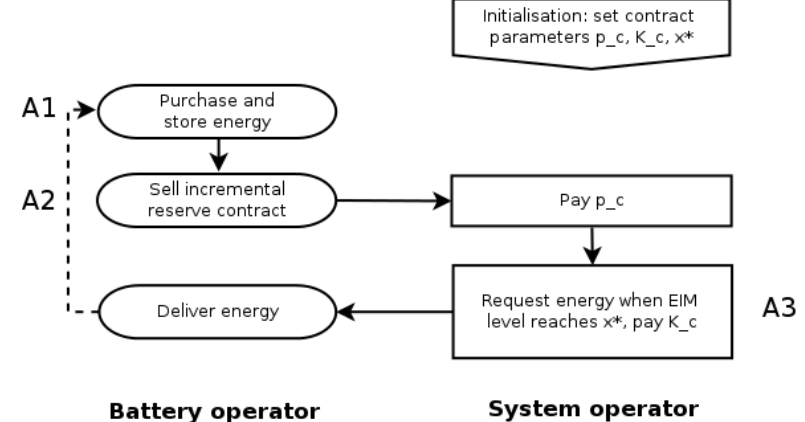
Figure 1. The sequence of actions